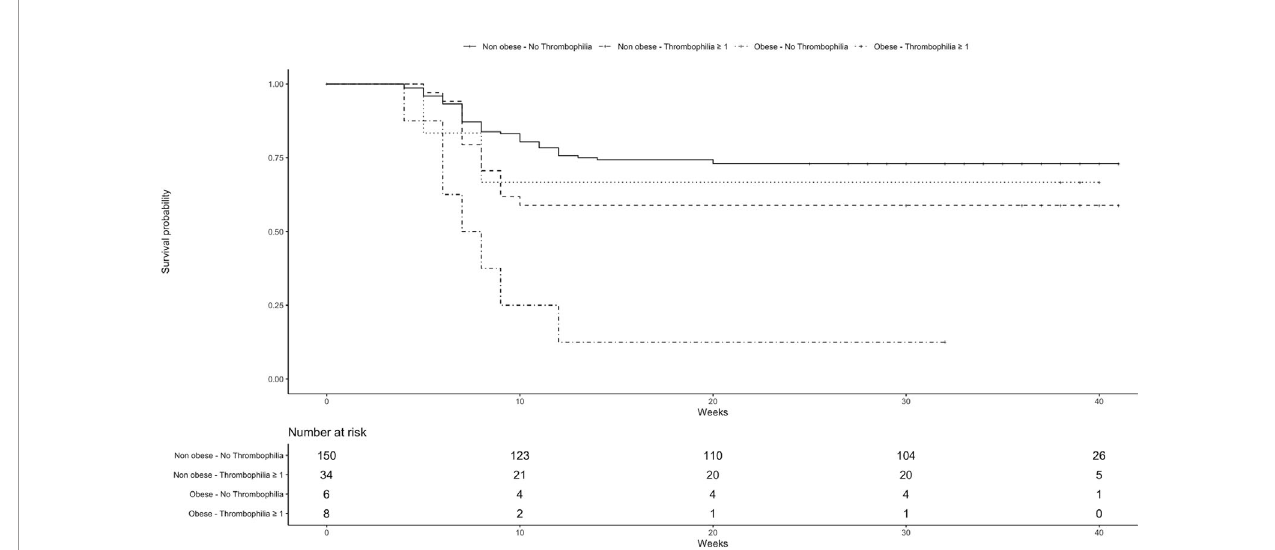
FIGURE 2 | Kaplan-Meyer curves for